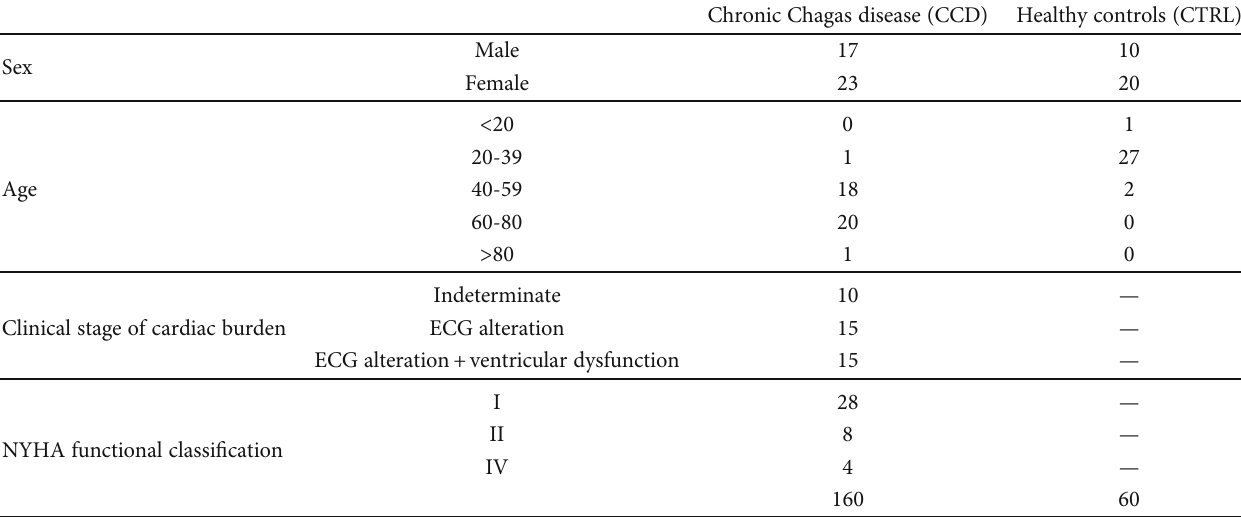
Table 1: Patients ’ and controls ’ baseline and clinical characteristics. Chronic Chagas disease patients (CCD; n = 40 ) and controls (CTRL; n = 30